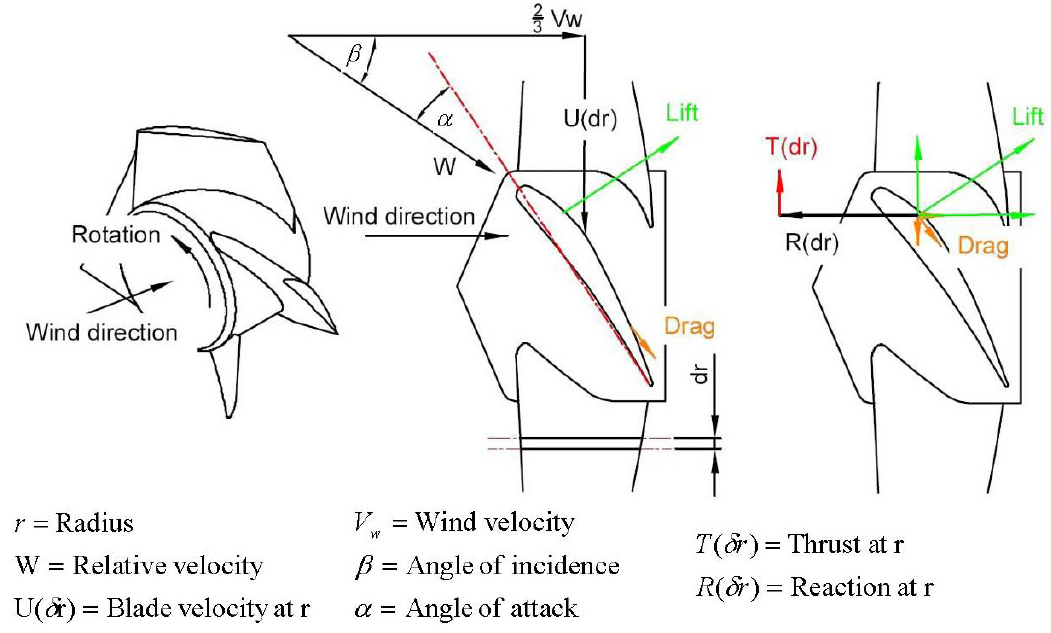
Figure 9. Aerodynamic forces generated at a blade